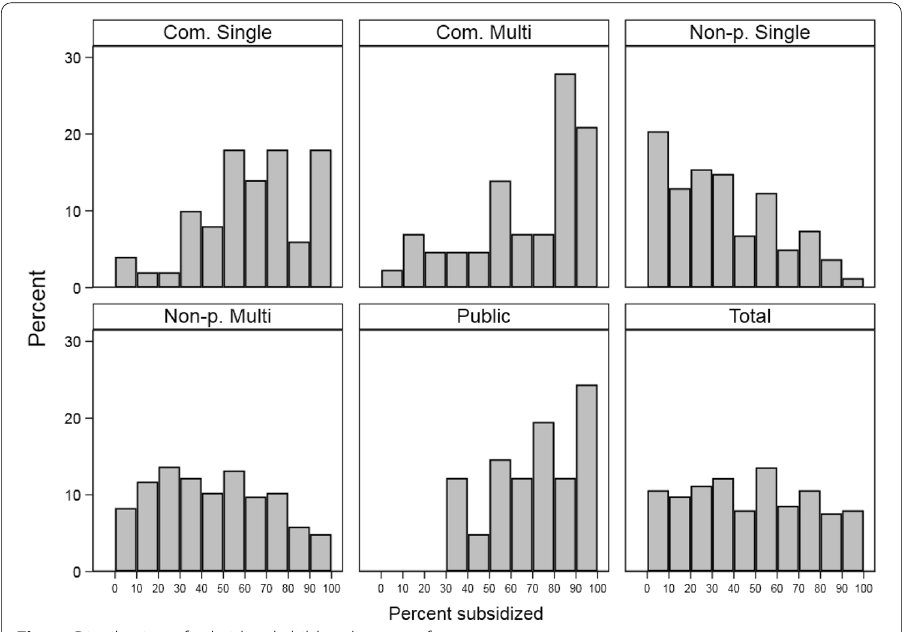
Fig. 1 Distribution of subsidized children by type of